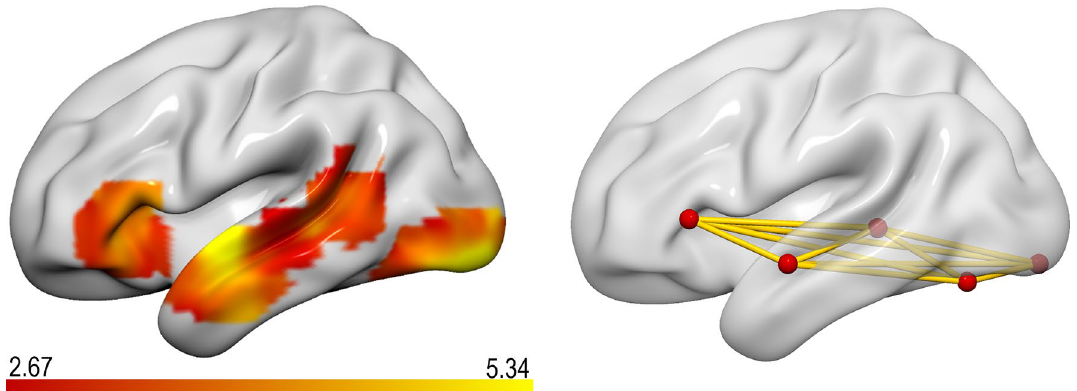
Figure 2. The left panel illustrates those brain regions, which showed a decrease in activation for words with increasingly higher predictability. The right panel illustrates the location of the selected ROIs for the functional connectivity analysis. Images were generated using the Surf Ice tool (version v2.1.51–0) for visualizing connectome networks, tractography and statistical maps (https:// www. nitrc. org/ proje cts/ surfi